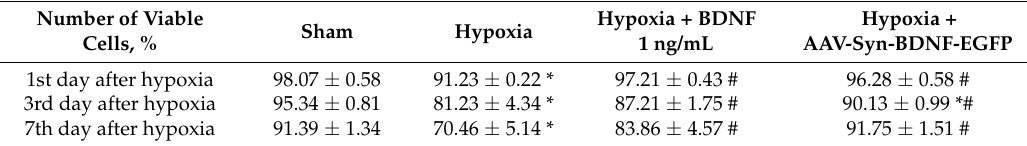
Hypoxia + BDNF Hypoxia + 1 ng/mL AAV-Syn-BDNF-EGFP